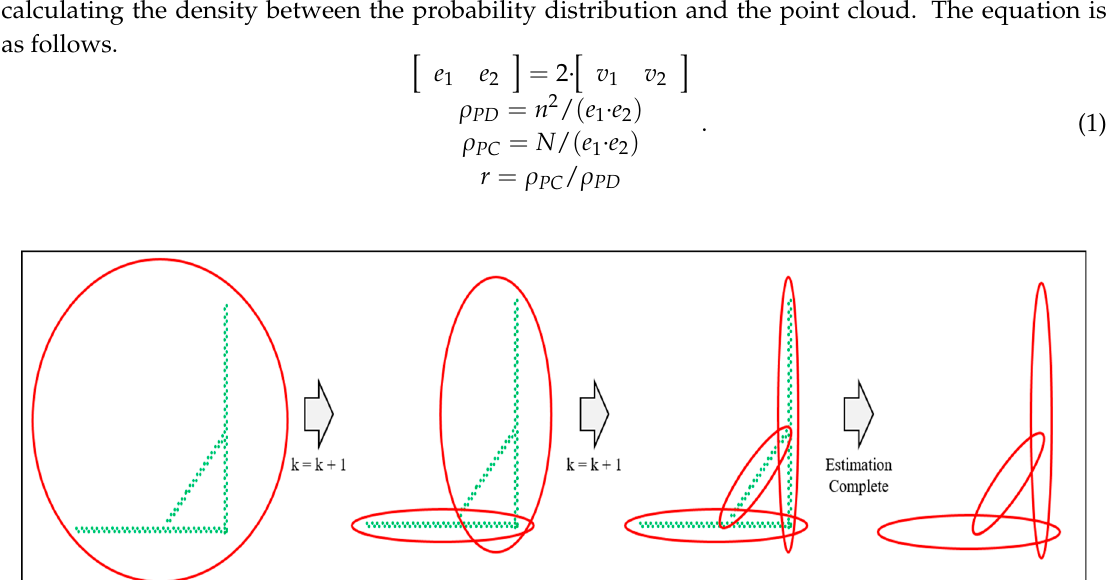
Figure 15. Example of increasing the number of probability distributions.